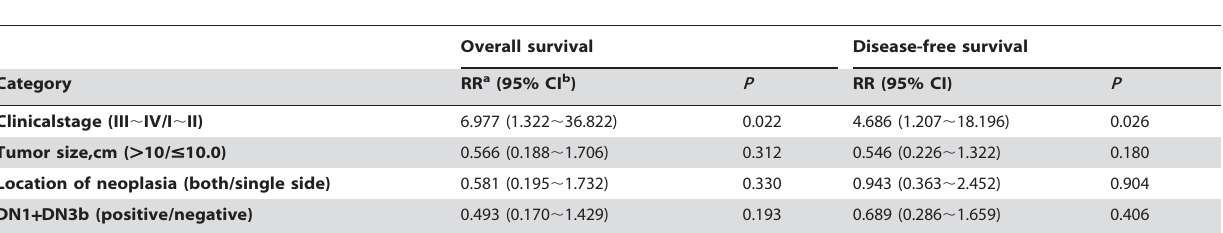
Table 6. Multivariate Cox Regression analysis of OS and DFS in ovarian